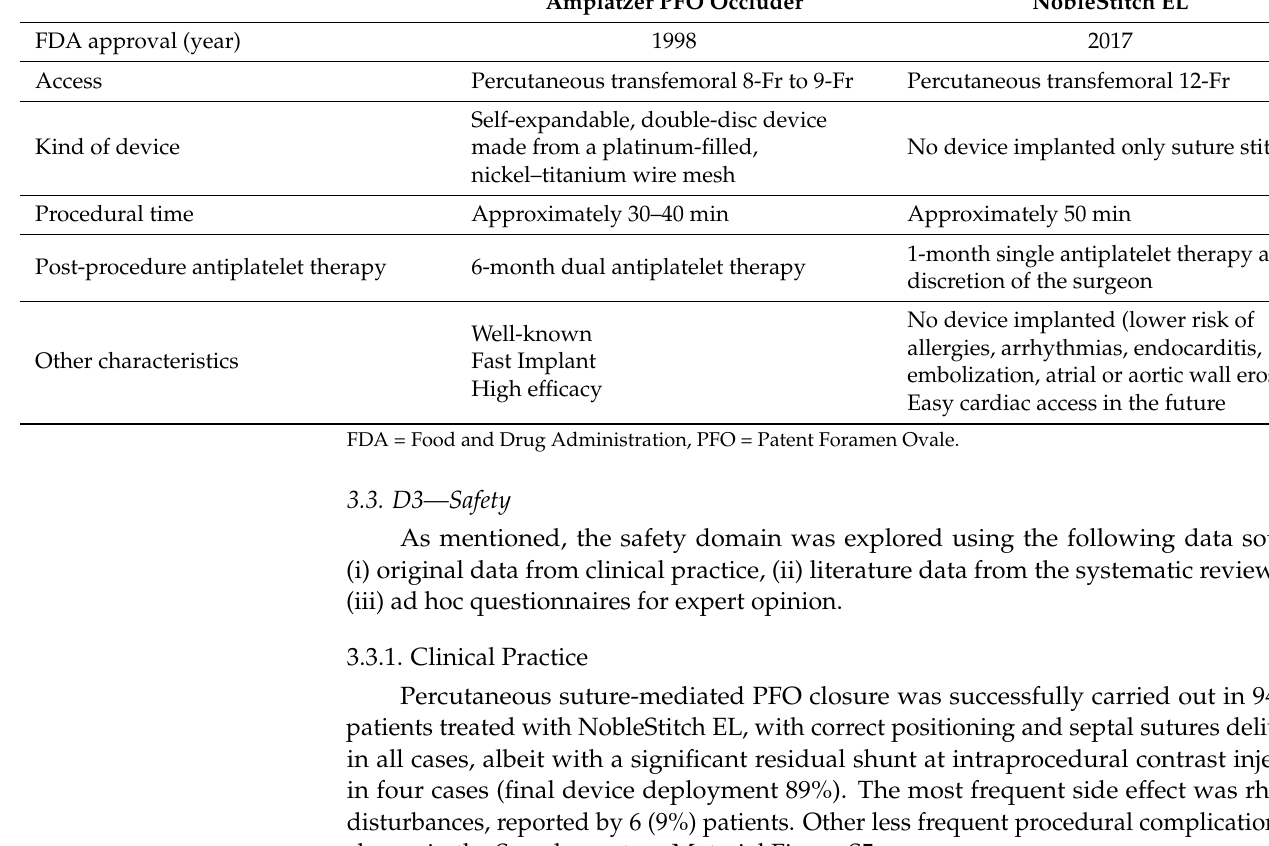
Table 2. Comparison between NobleStitch EL and Amplatzer PFO Occluder. Amplatzer PFO